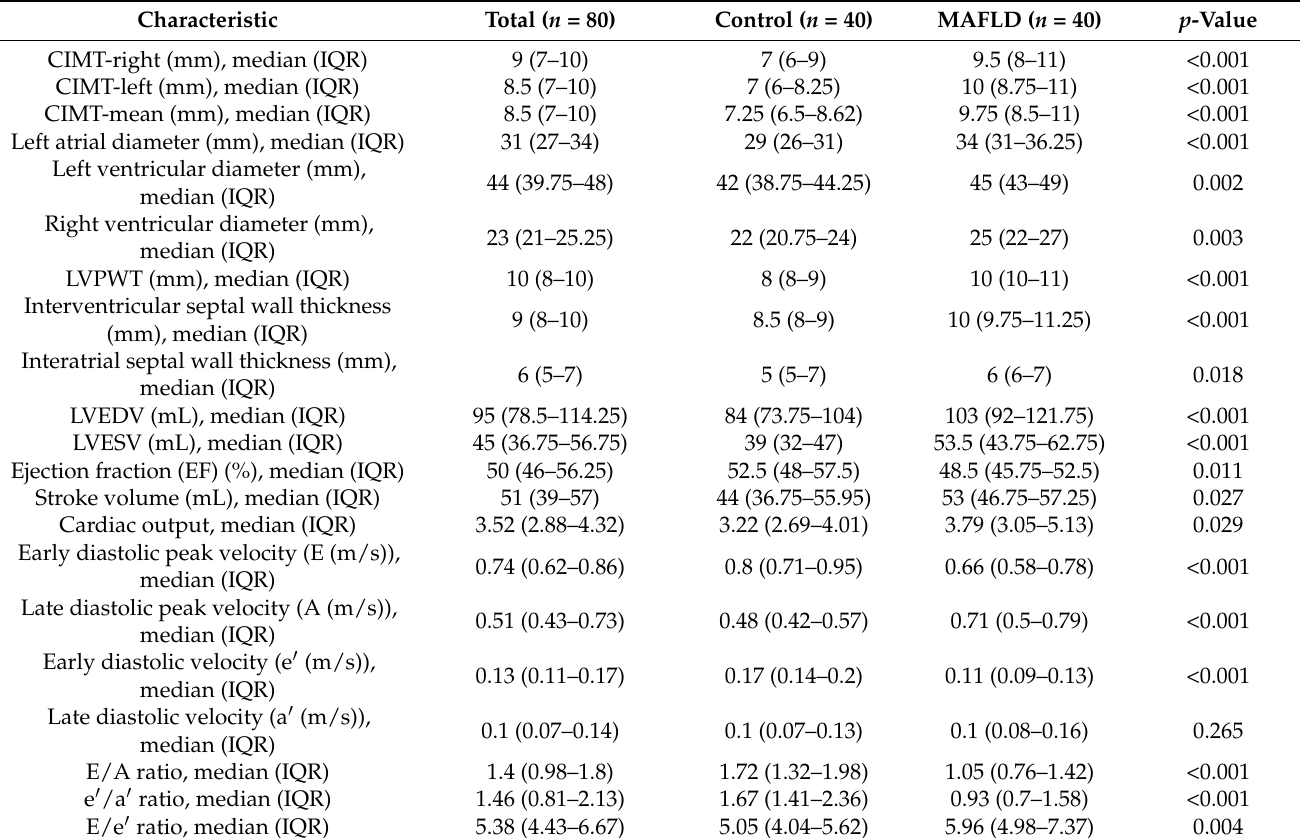
Table 2. Echocardiographic and Doppler ultrasound cardiovascular